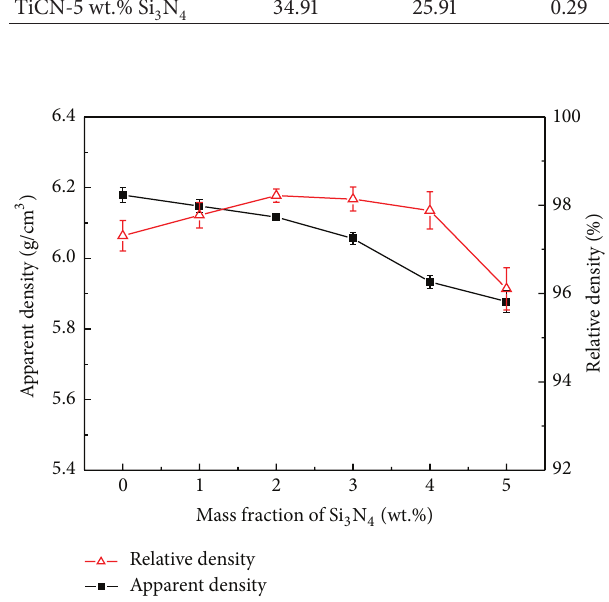
Figure 3: Apparent and relative densities of the as-prepared TiCN- based cermets as a function of mass fraction of Si 3 N 4